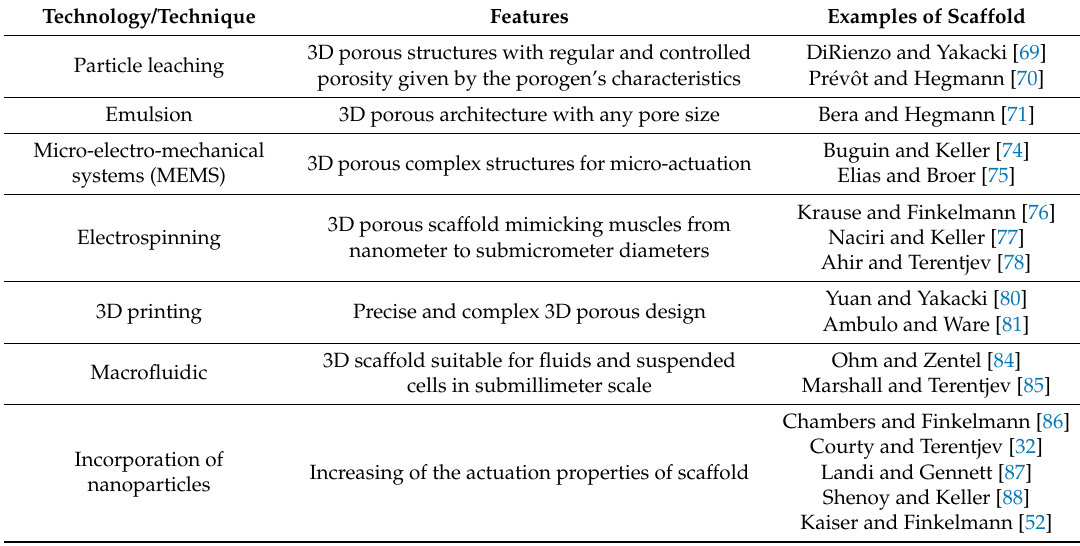
Table 3. Overview of technologies and techniques used to implement geometries and actuation properties of LCE scaffolds for tissue